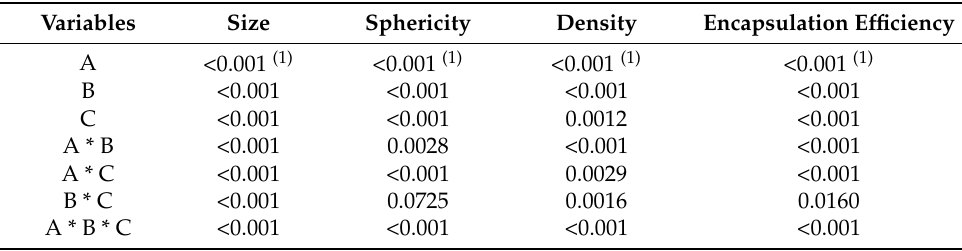
Table 3. ANOVA p-values showing the effect of the main studied factors and their interactions on the morphological and physical properties of the